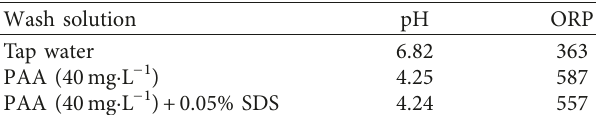
Figure 1: Relationship between grit removed per g of coral lettuce and spinach and % SDS concentration (SDS � sodium dodecyl sulphate). Table 2: pH and ORP values for wash water solutions used in experiment 2.